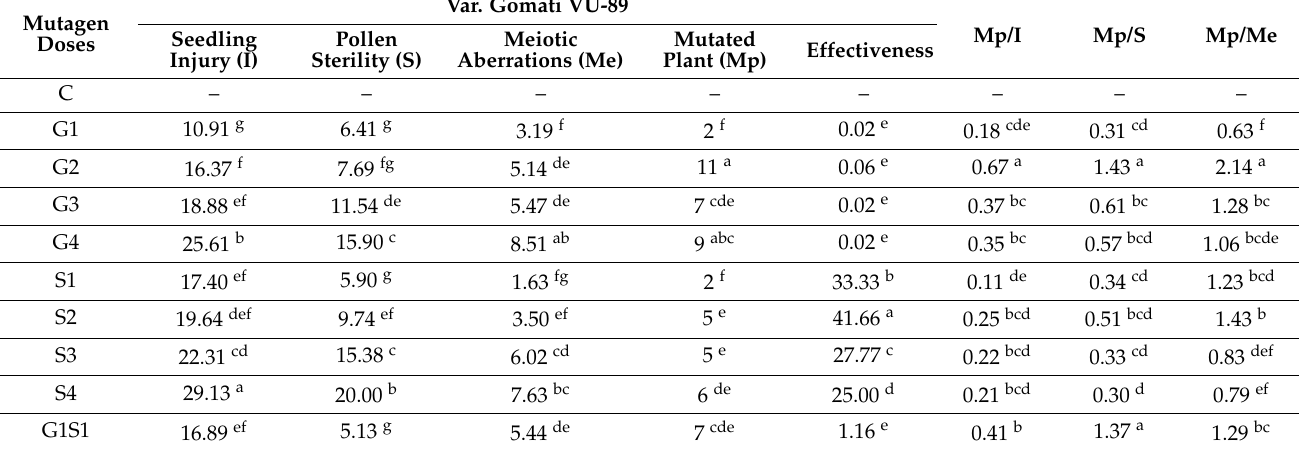
Table 4. Effectiveness and efficiency of γ rays, SA, and γ rays + SA treatments in cowpea varieties Gomati VU-89 and